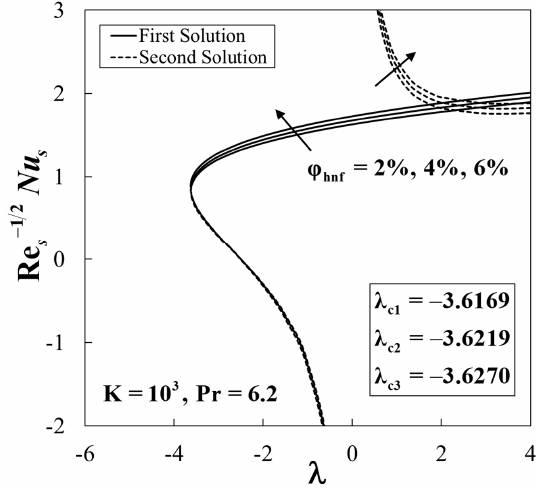
Figure 3. Variation of the local Nusselt number Re − 1/2 s Nu s against the mixed convection parameter λ for different values of ϕ hnf .